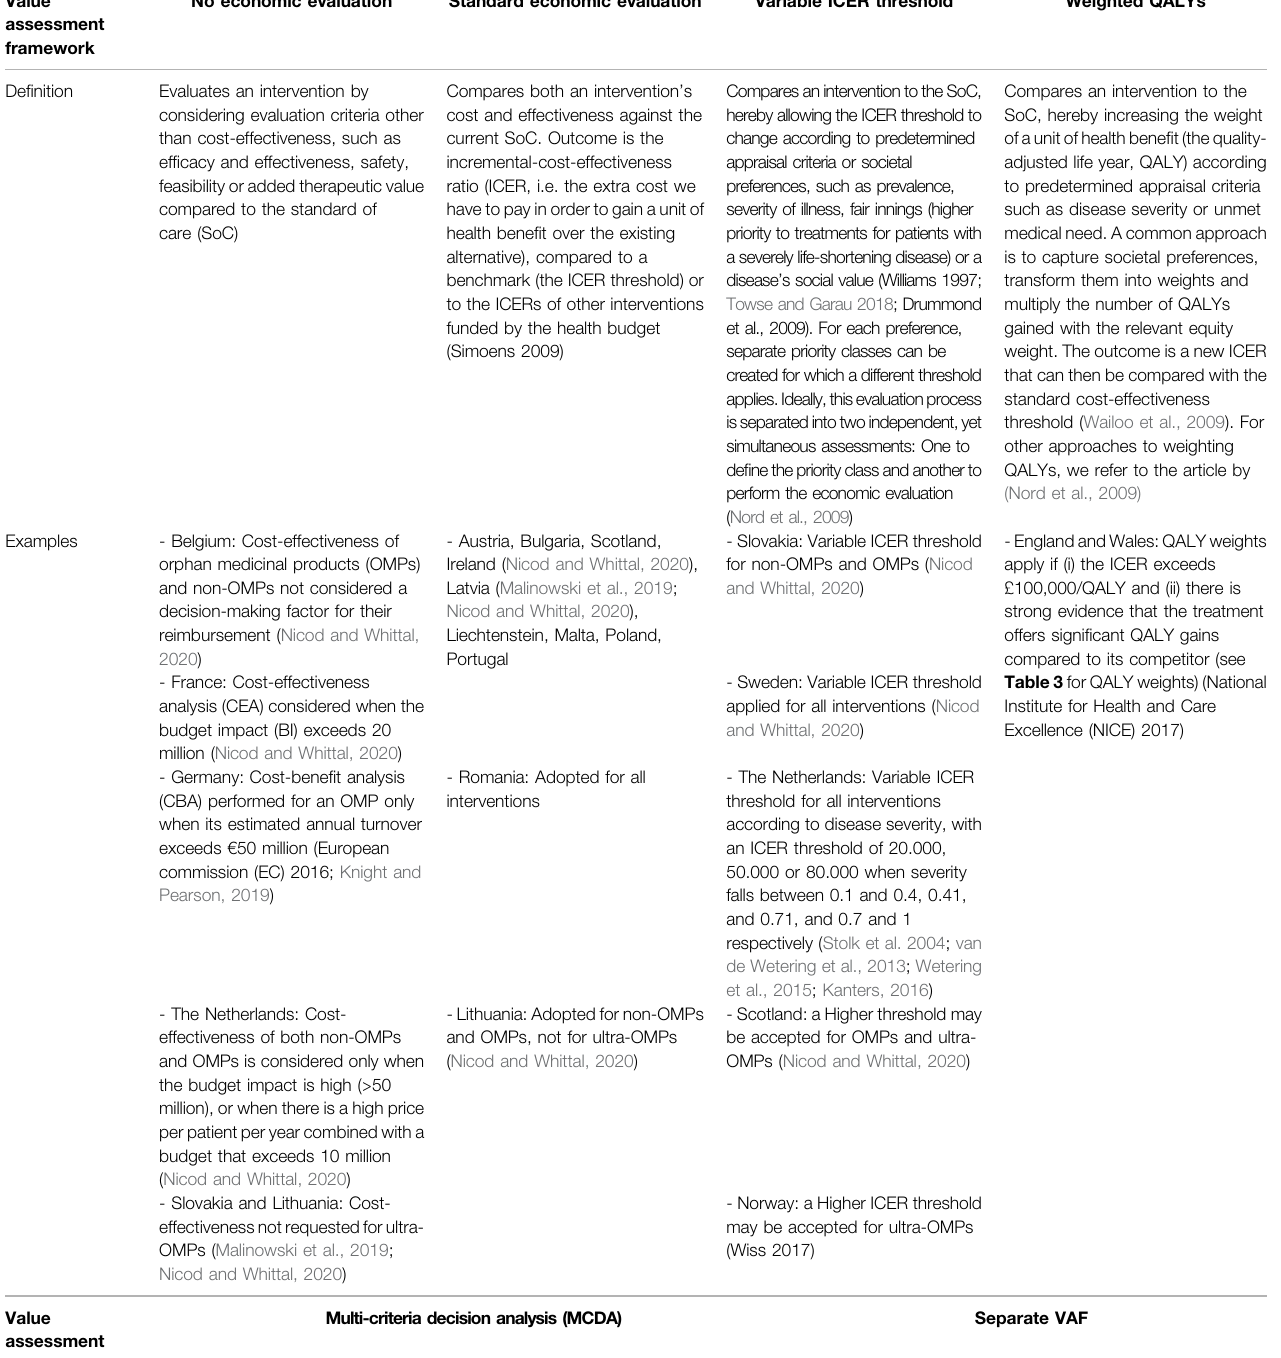
TABLE 1 | An explanation ofthe different value assessment frameworks in the context of (ultra-)OMPs and their implementation in jurisdictions acrossgeographical